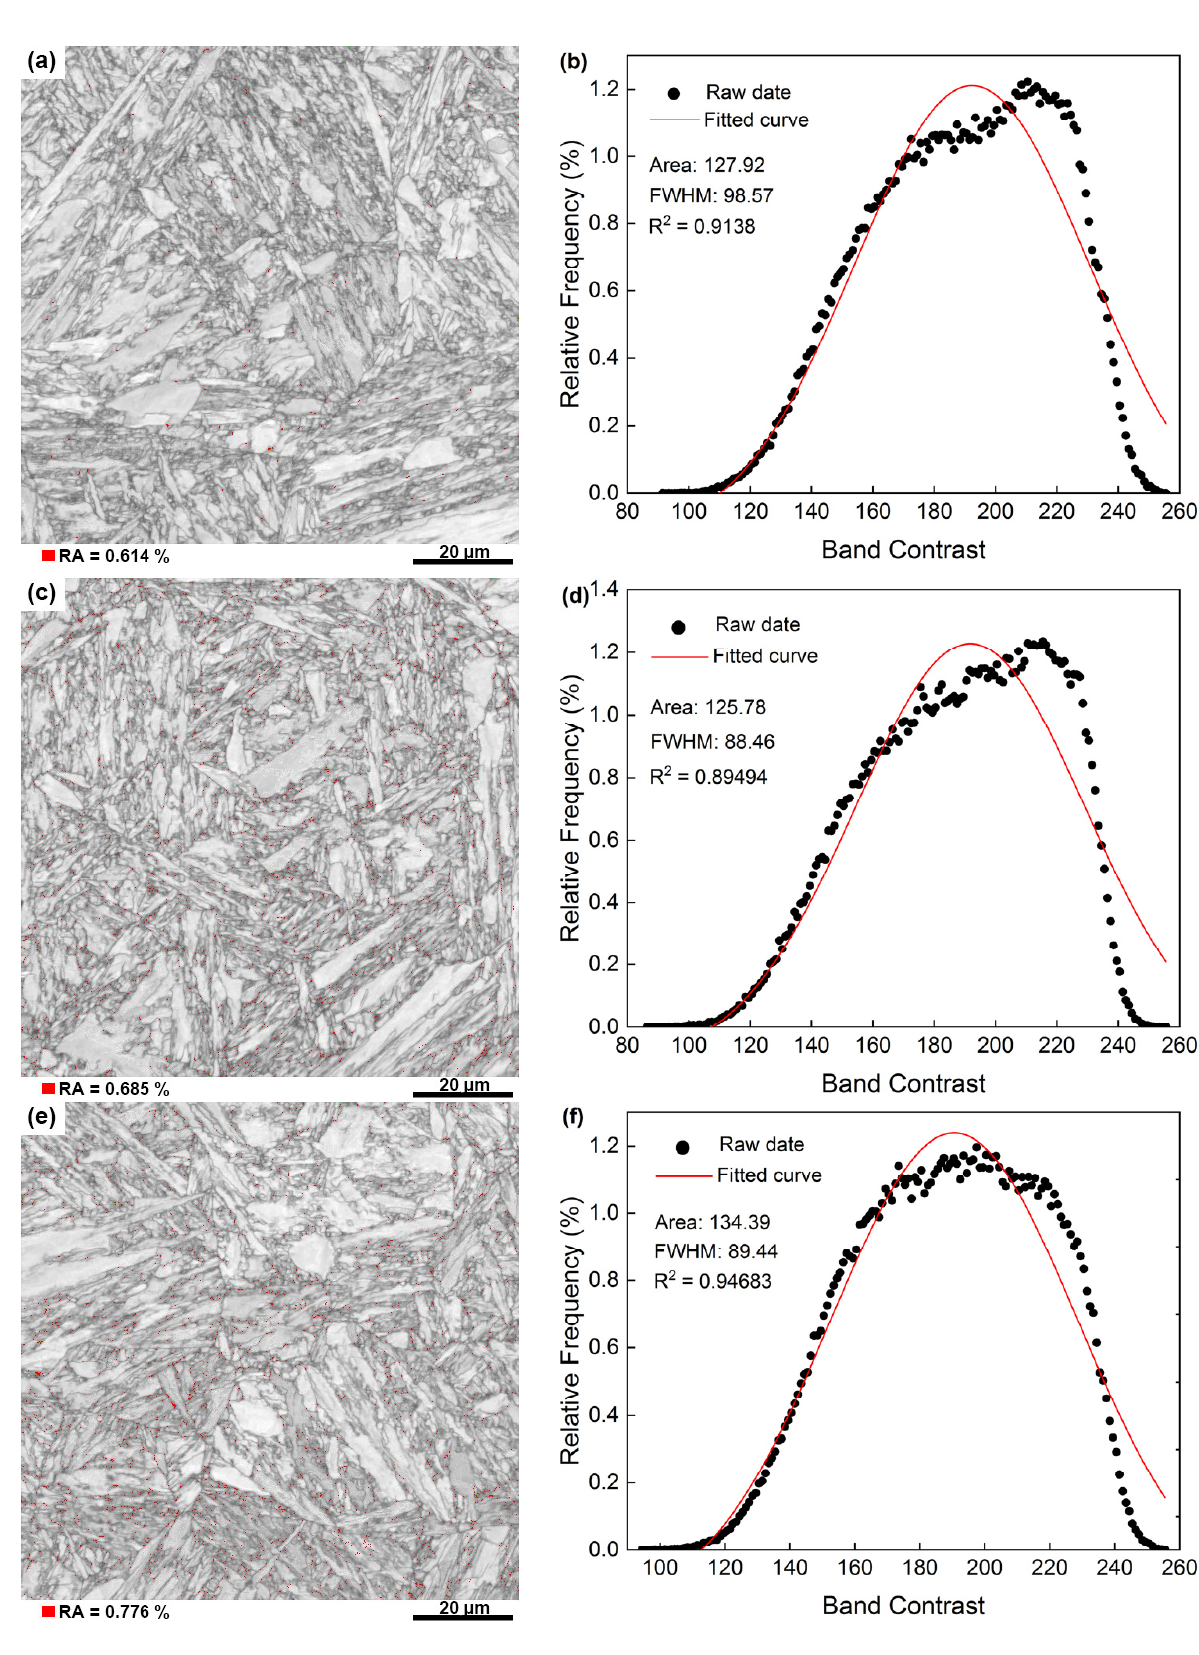
Figure 13. EBSD analysis using inverse pole figure maps: ( a ) 1300 °C, t 8/5 = 20 s; ( b ) 1250 °C, t 8/5 = 20 s; ( c ) 1200 °C, t 8/5 = 20 s.